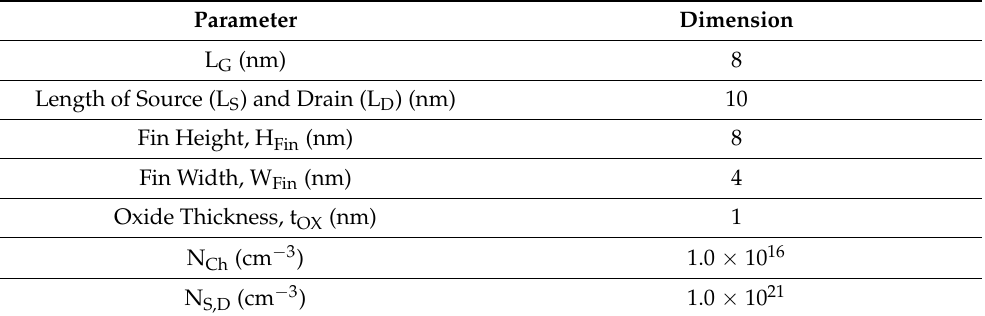
Figure 1. ( a ) Three-dimensional Device structure of GaN-SOI-FinFET, ( b ) 2D view of GaN-SOI-FinFET, and ( c ) 3D meshed device structure. Table 1. Device Parameters.